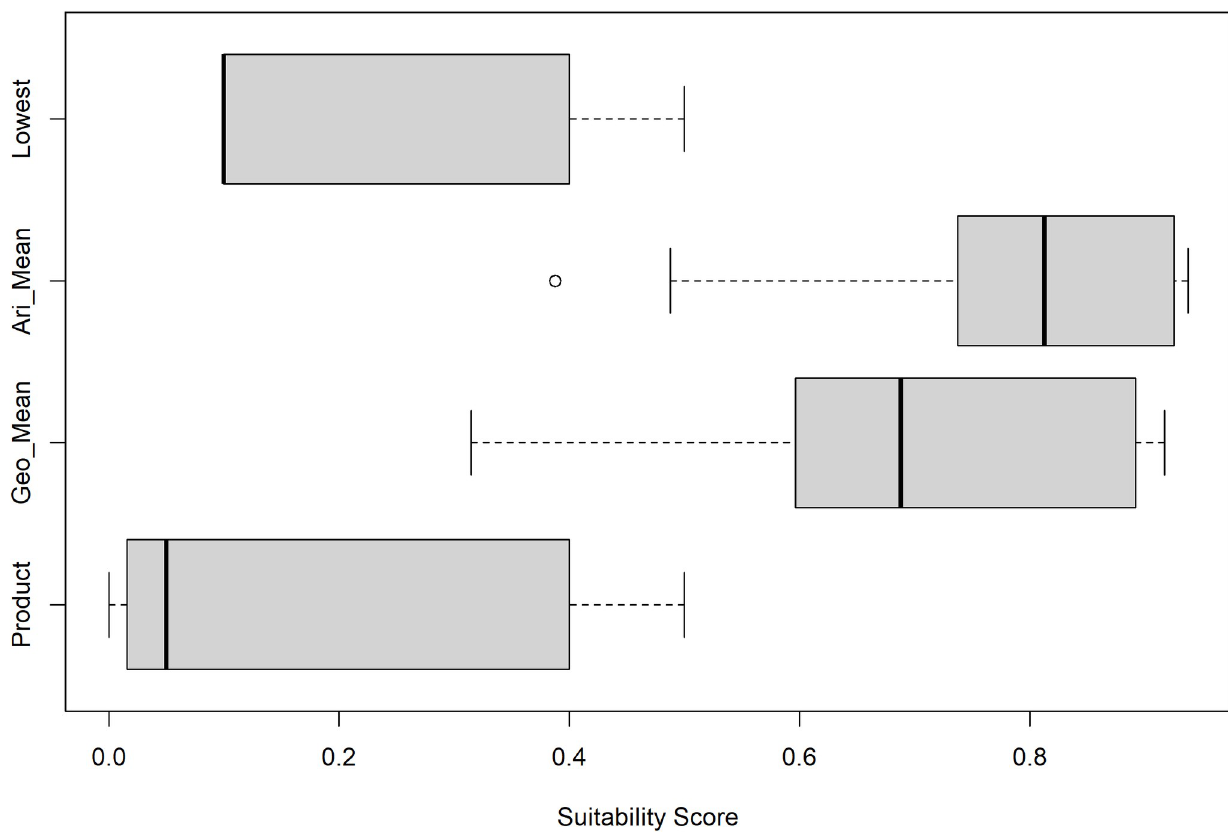
Fig 7. Comparison of scoring methods for combining protected species data layers. Boxplots comparing suitability scores for protected species across the entire Gulf of Mexico study area under Product, Geometric mean, Arithmetic mean, and Lowest Scoring layer methods. Lower scores denote greater